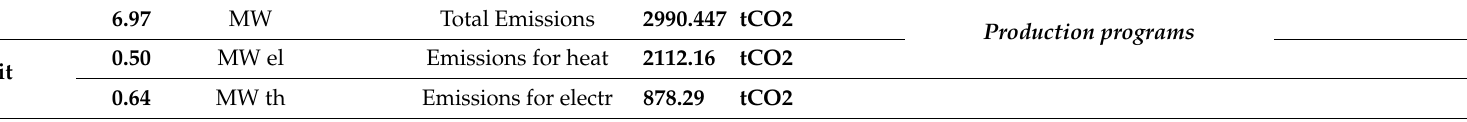
Table 2. Production program for “Low refurbishment rate”